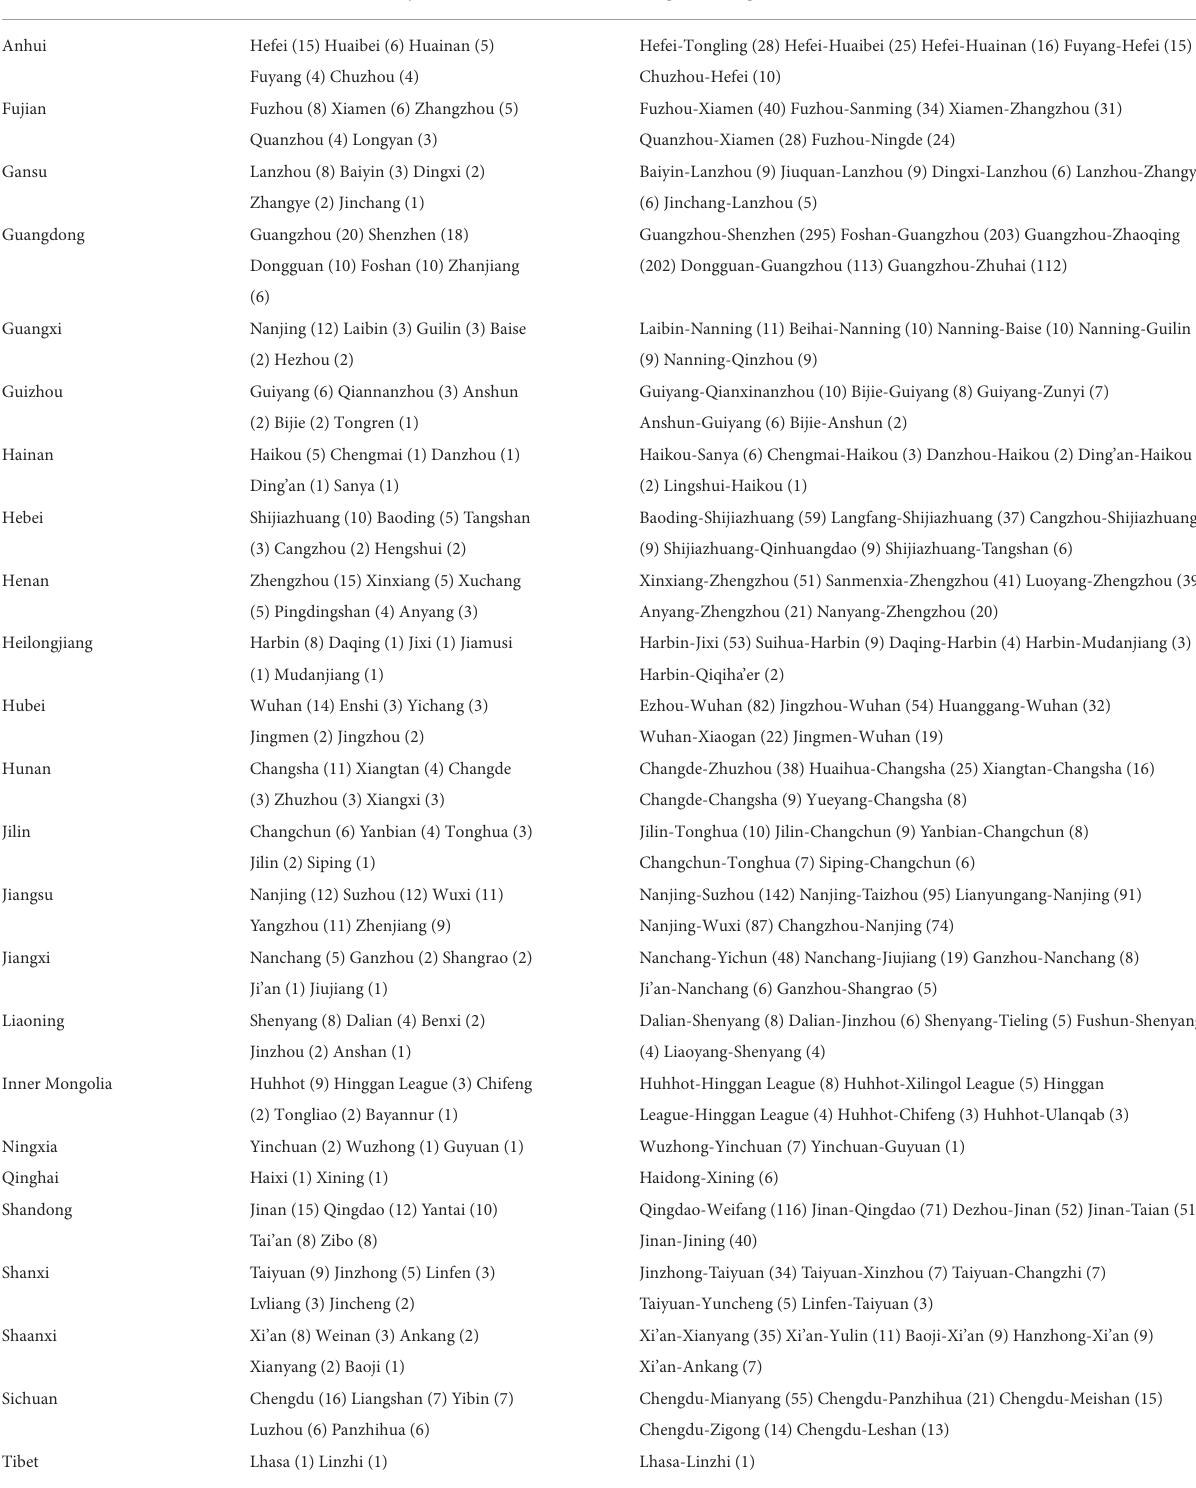
TABLE 8 Statistical characteristics of the intra-provincial urban biomedicine innovation networks of all Chinese provinces in the 2016–2020 period.